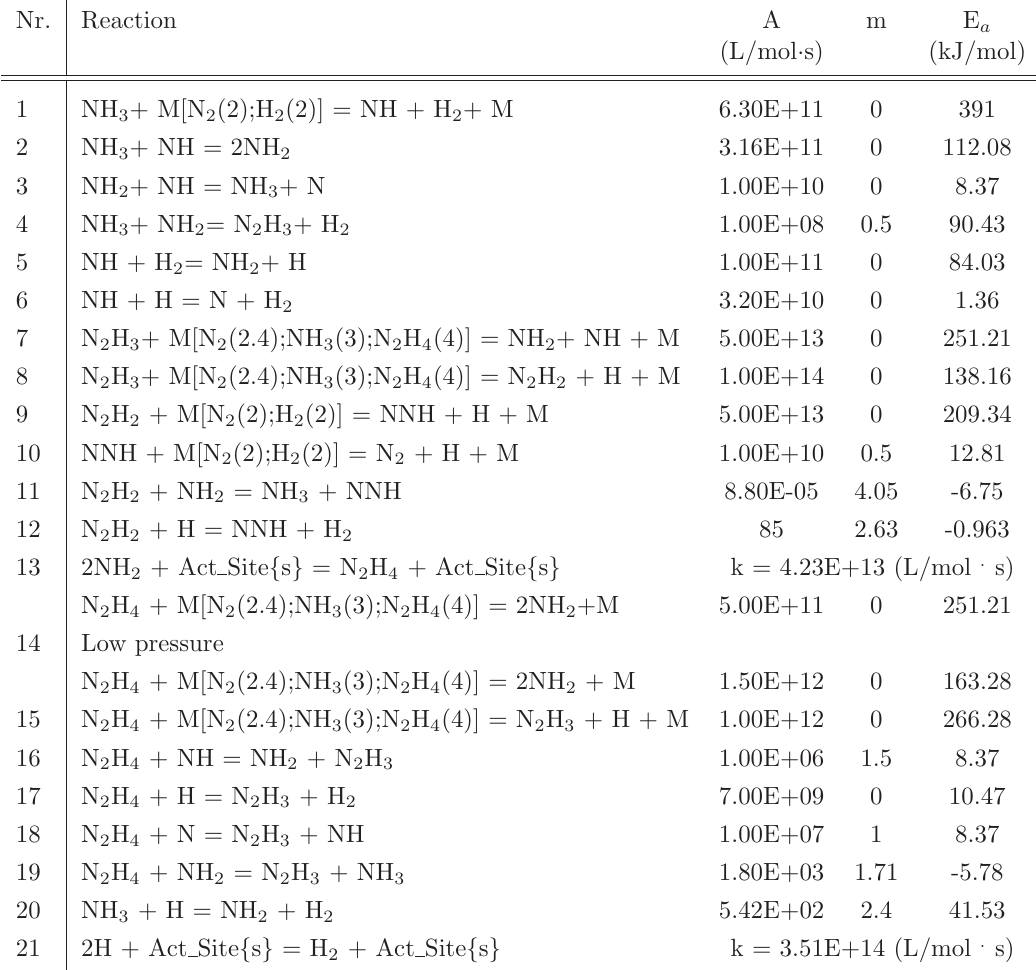
Table 1 Reduced pattern for the mechanism of NH 3 thermal